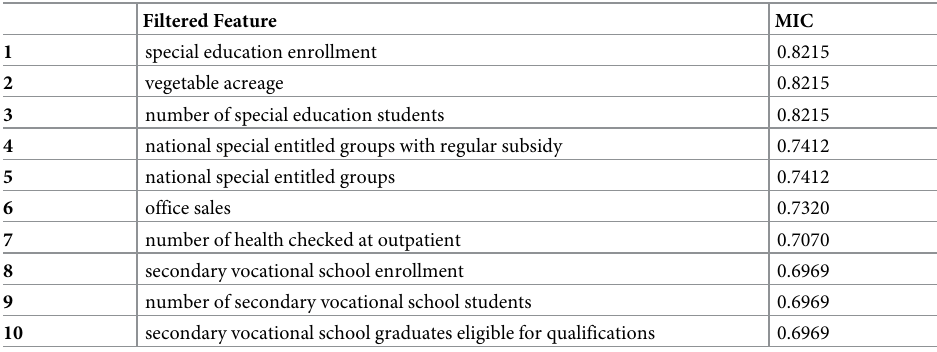
Table 3. Top 10 high scoring features for MIC measure.